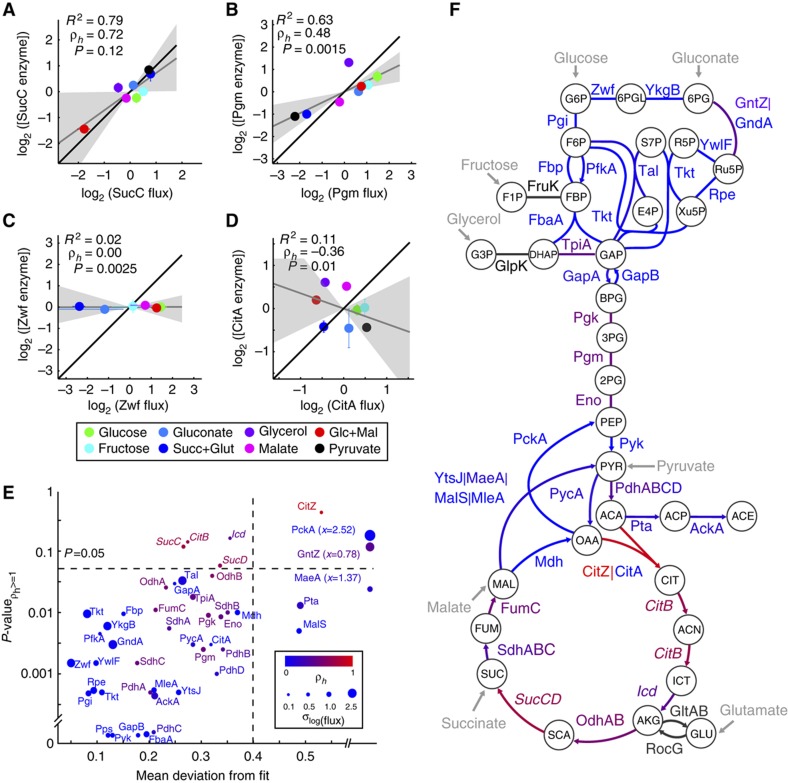
Correlation of flux and enzyme concentration (inferred from transcripts) changes for reactions in central metabolism. Four typical cases are shown in (A–D). Both X and Y data are log2-transformed and normalized by subtracting the mean, forcing the line of best fit to pass through the origin. For each plot, the coefficient of determination (R2) and the slope (ρh) of the line of best fit (gray) are given, along with P, the P-value associated with the hypothesis ρh>1 (see Materials and methods). The shaded area corresponds to a 95% confidence interval of the fitted slope and the black line corresponds to ρh=1. (E) Scatter plot of P-values and goodness of linear fit for each reaction. To distinguish cases like (C) from (D), both of which give R2≈0, we take the mean value of the residuals as the goodness of fit for the purpose of this plot. Symbol size corresponds to the deviation in flux values (considering only fluxes greater than the cutoff of 0.1 mmol gcdw−1 h−1). Color corresponds to ρh values (the slope of the fitted line). Enzymes where P<0.05 (i.e., ρh=1 cannot be statistically excluded) and the mean residual value is <0.4 (i.e., good fit) are shown in italic. Some points that overlap perfectly have been offset slightly for visibility. (F) Graphical representation of ρh values for each enzyme in central carbon metabolism. Color legend and fonts are identical to (E).